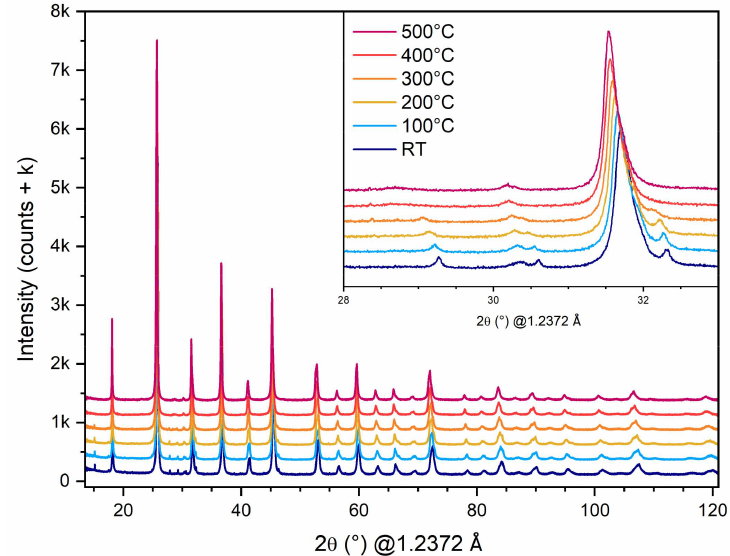
Figure 4. Synchrotron XRD patterns of the as-prepared LBM sample heated from RT to 500 ◦ C in air. Note that the peaks at ~29 ◦ and ~32 ◦ (inset) almost disappear at 300 ◦ C indicating the oxygen uptake with the formation of cation vacancies and transformation of the orthorhombic to rhombohedral phase.